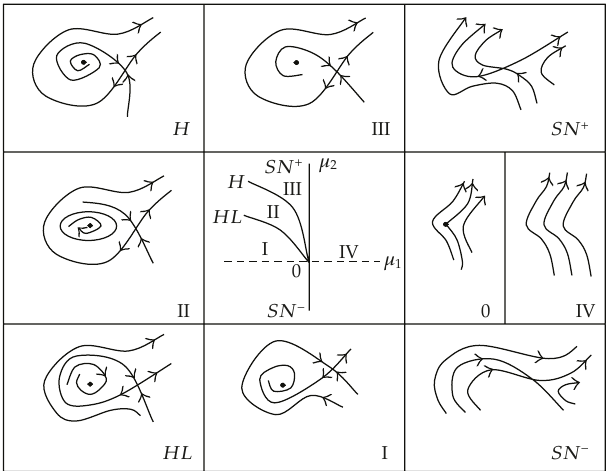
Figure 1: The bifurcation set and the corresponding phase portraits of system (cid:2) 3.26 (cid:3) at